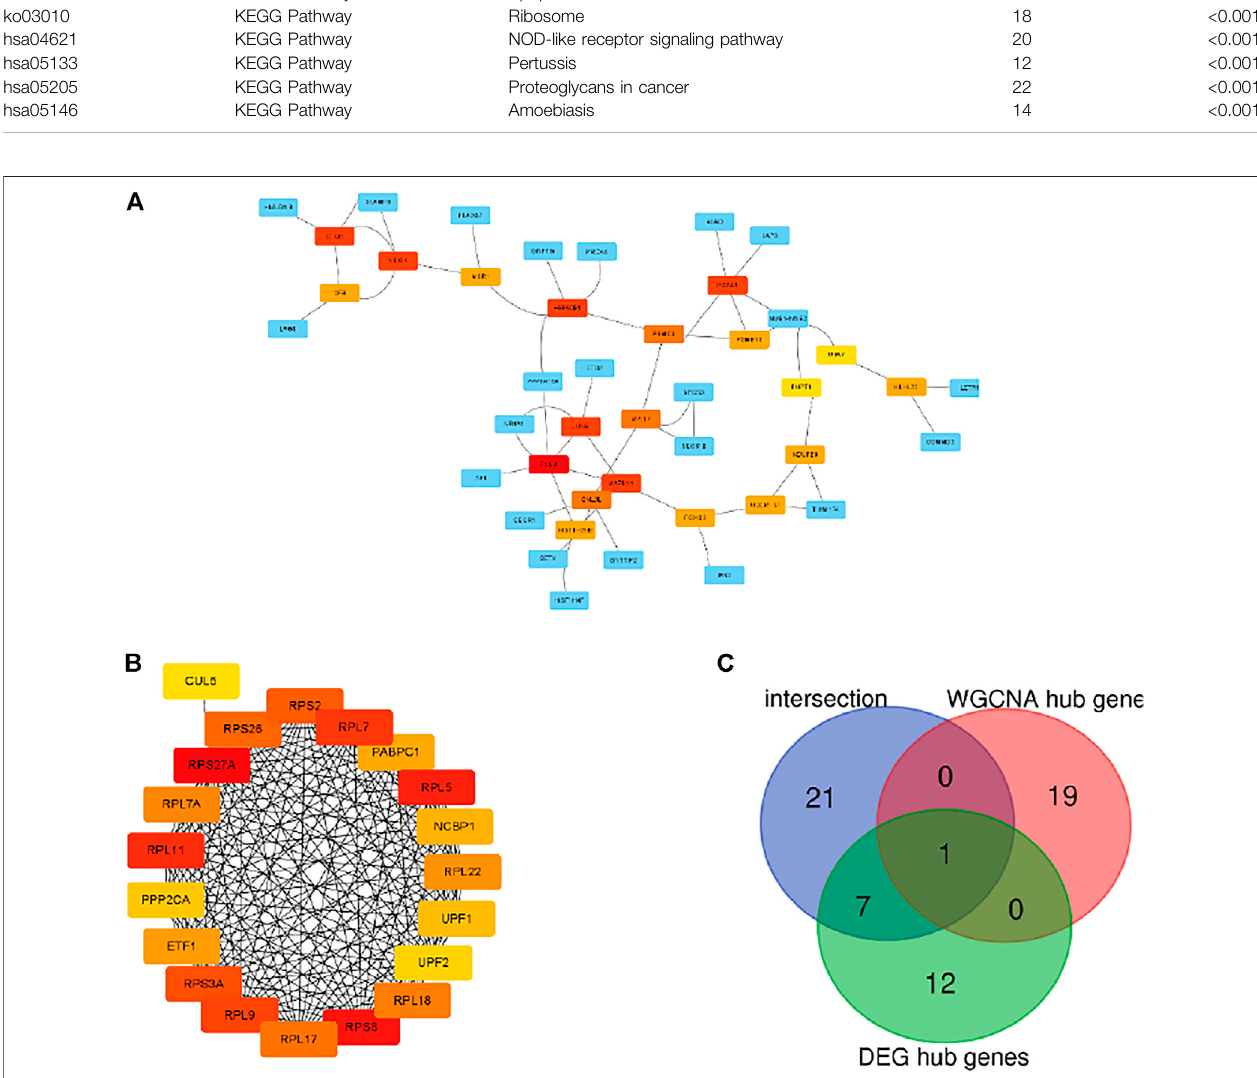
FIGURE 5 | Visualization of the protein-protein interaction (PPI) network and the candidate hub genes. (A) PPI network of the hub genes of DEGs list. (B) Identi fi cation of the hub genes of WGCNA grey module from the PPI network using maximal clique centrality (MCC) algorithm. Edges represent the protein-protein associations. The red nodes represent genes with a high MCC sores, while the yellow node represent genes with a low MCC sore. (C) The venn diagram among intersection gene list, WGCNA hub gens and DEG hub genes.